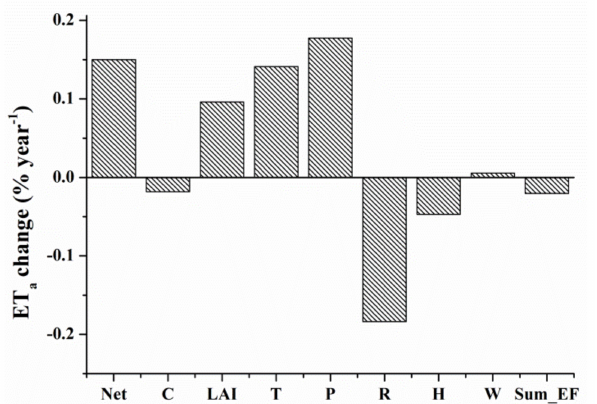
Figure 7. Contributions of changes in climate variables, the atmospheric CO 2 concentration and the leaf area index (LAI) to the ET a variation and their two-factor interactive effects (Net: total effect of all the variables, C: atmospheric CO 2 concentration, T: temperature, P: precipitation, R: radiation, H: vapor pressure, W: wind speed, Sum_EF: sum of all the two-factor interactive effects of variables).